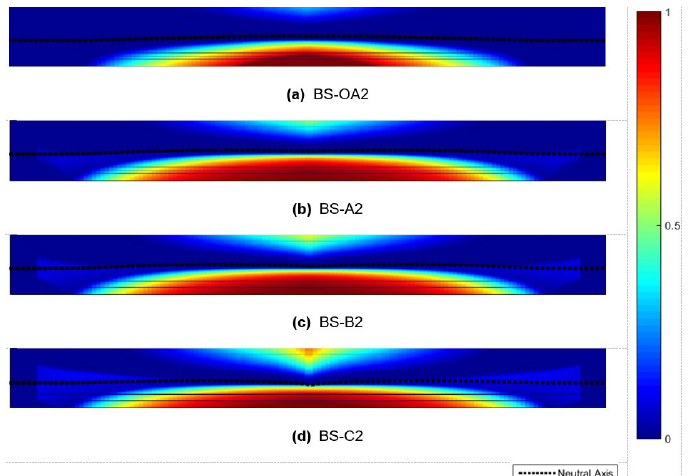
Figure 11. Final damage configuration for Bresler-Scordelis' series 2